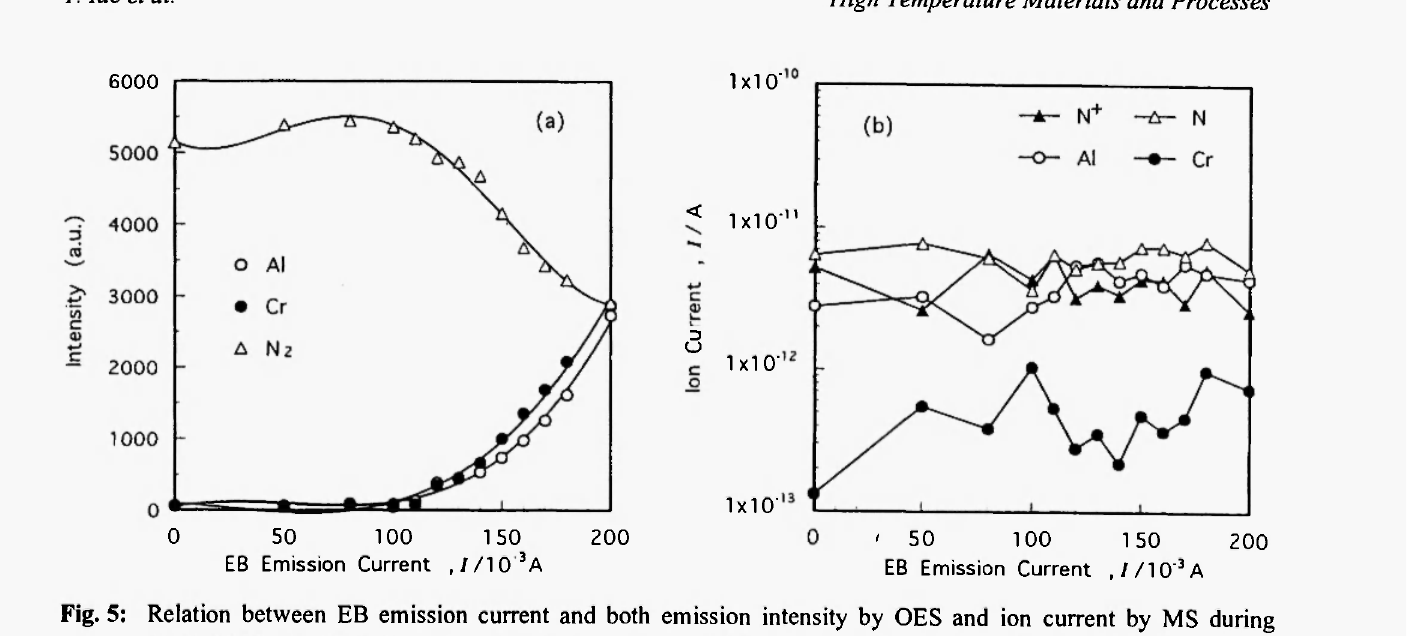
Fig. 5: Relation between EB emission current and both emission intensity by OES and ion current by MS during Al-Cr-N film in ARE. (Type B, EB emission current = 0.21 A, probe voltage = 90V, N 2 flow rate = 5.83 χ 10" 7 m 3 /s) (a) OES, (b) MS.